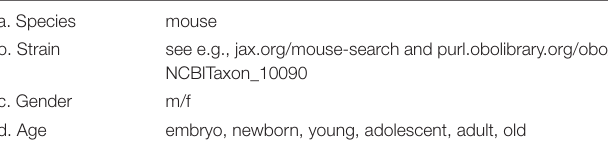
TABLE 2 | Basic features that apply to all neuron